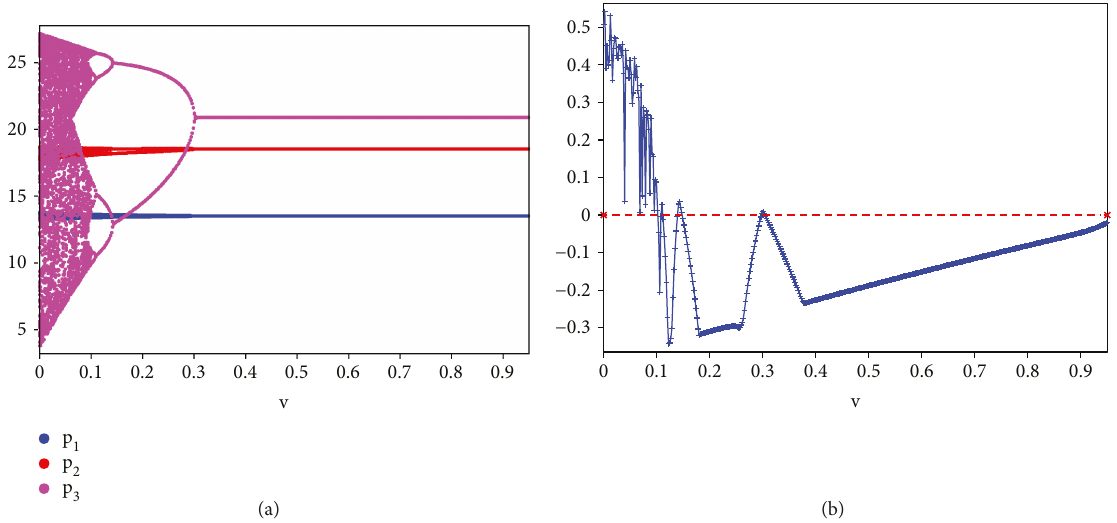
Figure 13: The in fl uence of v on the price evolution process of the system